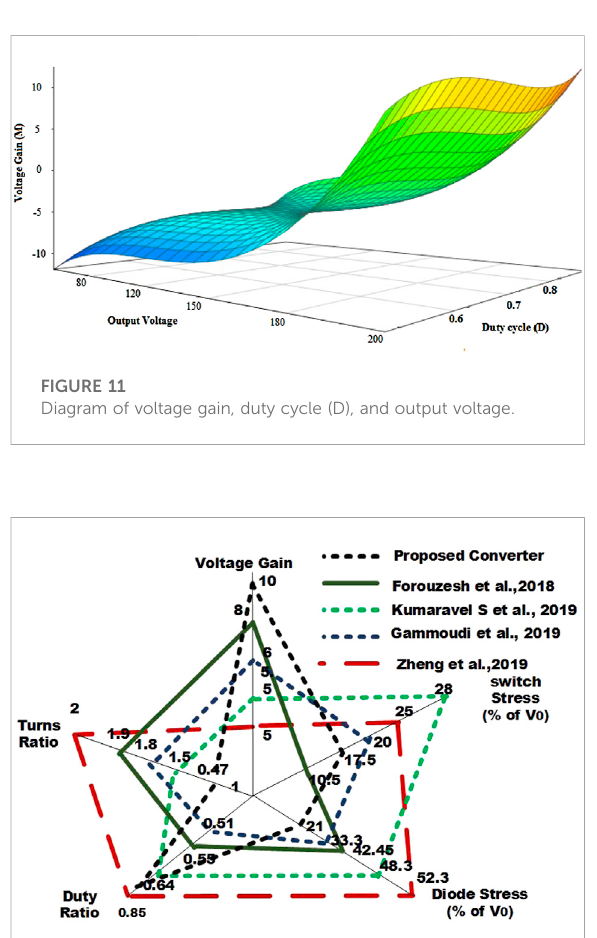
FIGURE 14 Voltage (Vds, Vgs) and current (Ids) across the